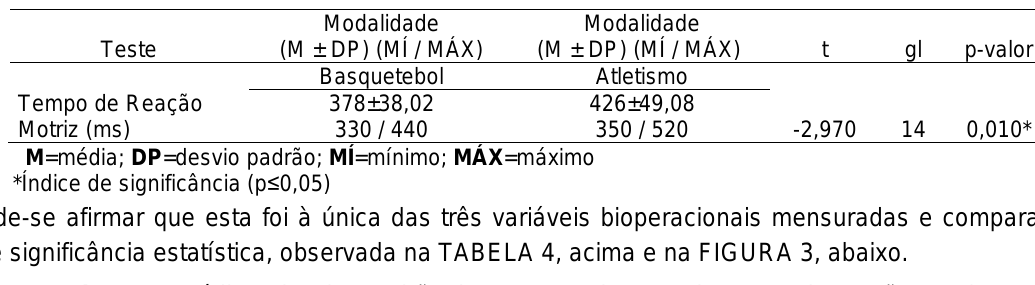
Figura 3. Média e desvios padrão dos escores do teste de tempo de reação motriz. TESTE DE TEMPO DE REAÇÃO